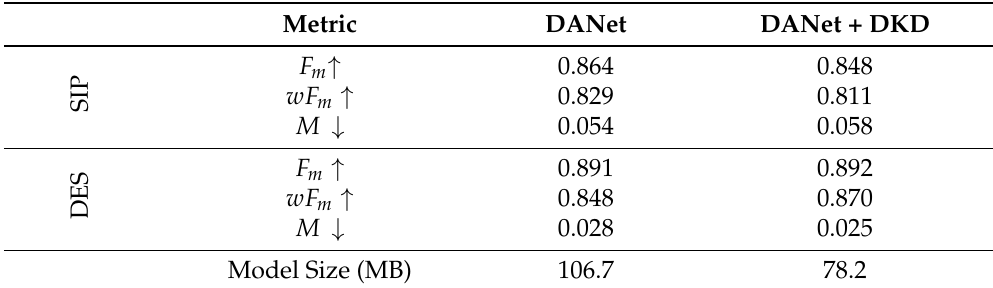
Table 4. Quantitative comparisons of applying DKD on DANet. We use the DANet as the teacher model and exploit the proposed DKD to transfer knowledge from DANet to the VGG-19 based FPN. ↑ and ↓ indicate that larger and smaller scores are better.